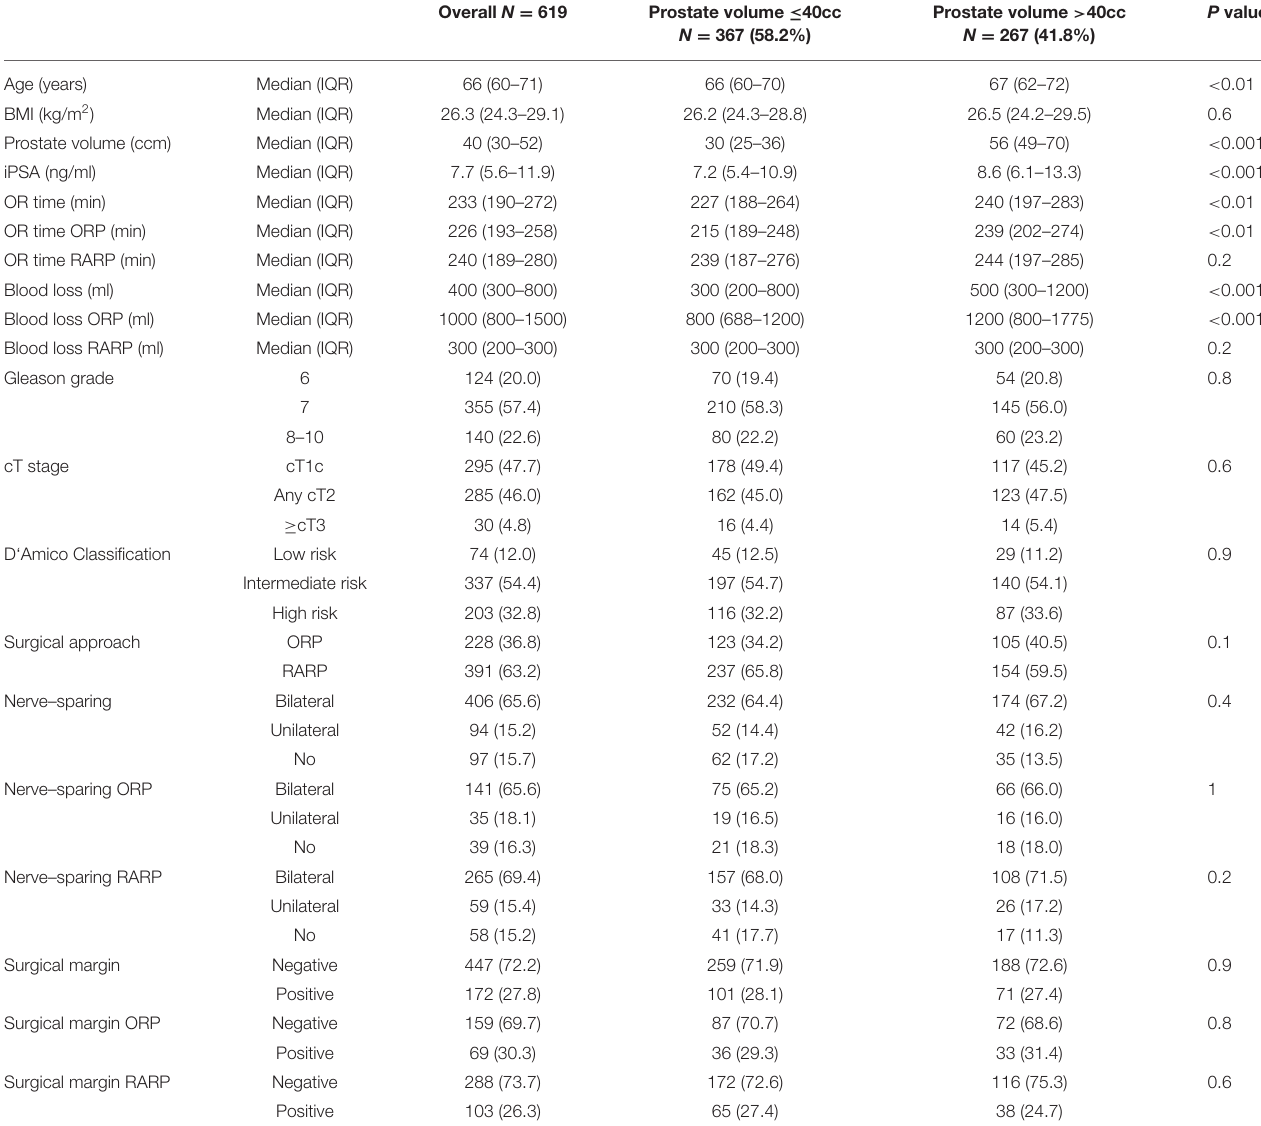
TABLE 1 | Patient characteristics stratified by prostate